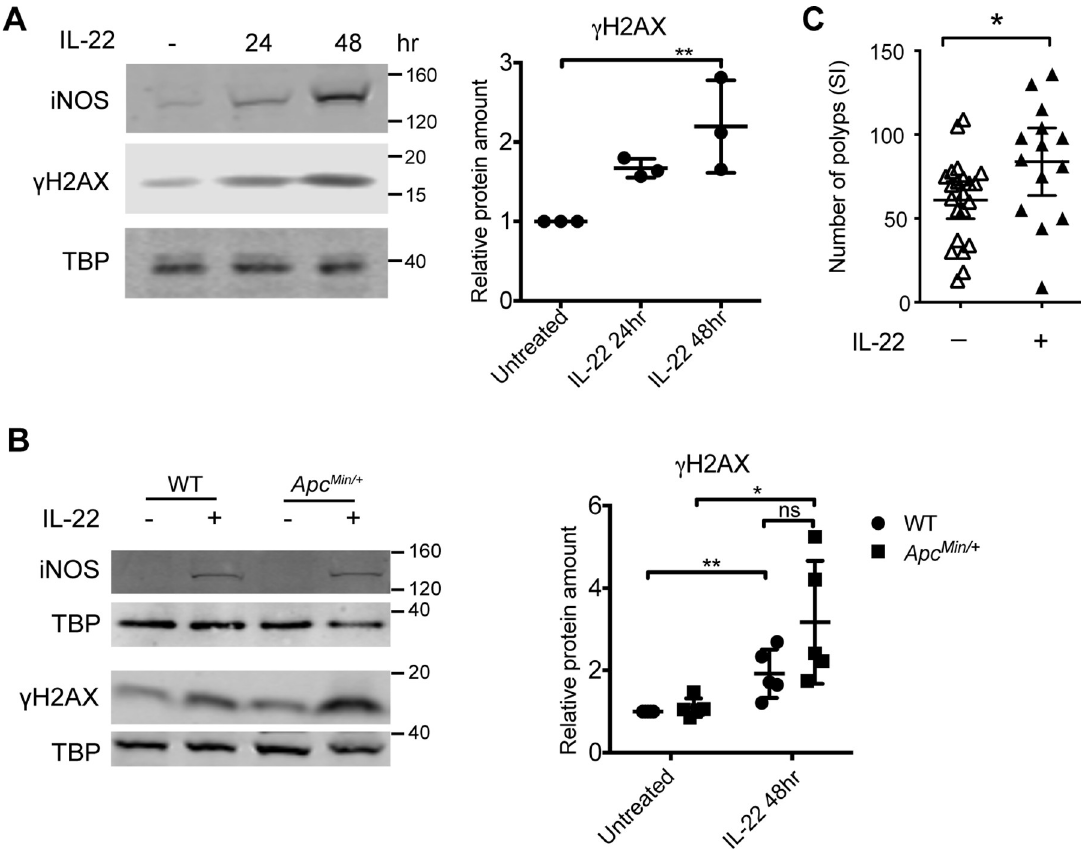
Fig 7. IL-22 increases iNOS and DNA damage in Apc Min/+ organoids. (A) Western blot of iNOS or γ H2AX in WT organoids treated with IL-22 (10 ng/ml) for 24 or 48 hours. (B) Western blotting for iNOS or γ H2AX in WT or Apc Min/+ organoids treated with IL-22 (10 ng/ml) for 48 hours. TBP was used as loading control. The ratio of γ H2AX to TBP in each sample was normalised to untreated control in each experiment. At least 3 independent experiments were performed. � p < 0.05, paired t test. (C) Apc Min/+ mice aged 27–30 days were injected twice a week for 4 weeks with 1 μ g IL-22 or PBS or were left untreated. Untreated and PBS-injected mice were pooled together for the “control” cohort (there was no difference in the tumour number in these two cohorts). � p < 0.05, unpaired t test. Numerical values for (A) and (B) are available in S1 Data. γ H2AX, Phospho-Histone H2A.X (Serine 139); Apc, adenomatous polyposis coli; IL-22, interleukin-22; iNOS, inducible nitric oxide synthase; SI, small intestine; TBP, TATA box binding protein; WT,